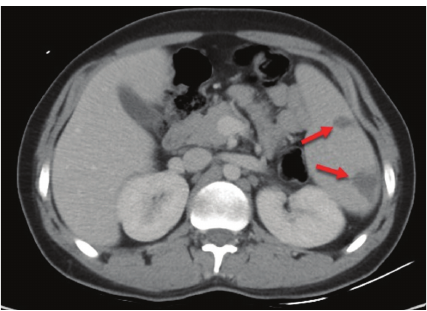
Figure 1: Abdomen CT without contrast showing multiple hypo- dense splenic lesions.